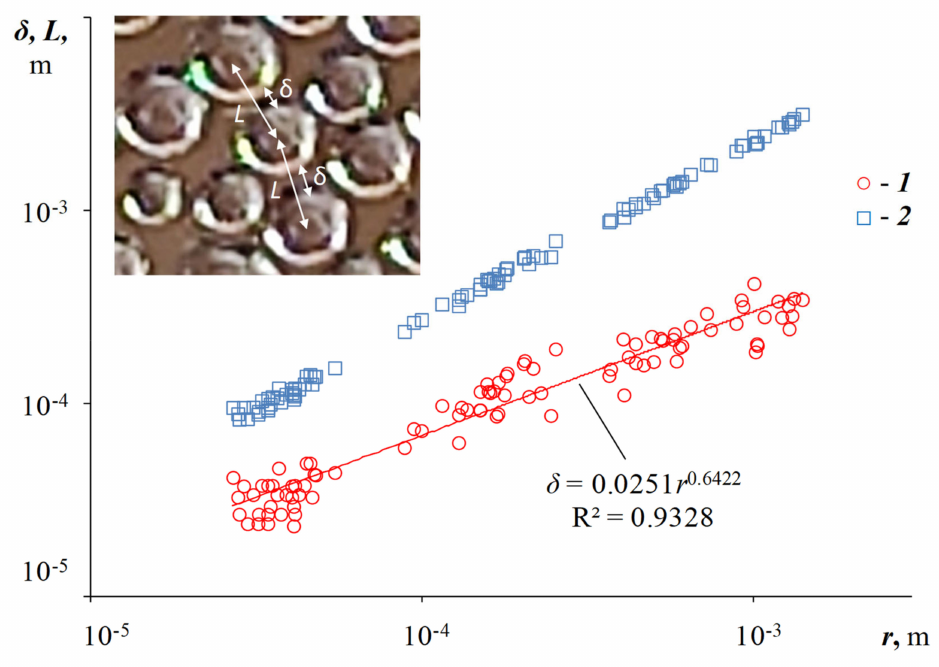
Figure 3. Dependence of the average distance between the surfaces of neighboring drops δ (1) and the average distance between the centers of neighboring drops L (2) on their average radius r . The inset shows a fragment of a photograph of the droplet